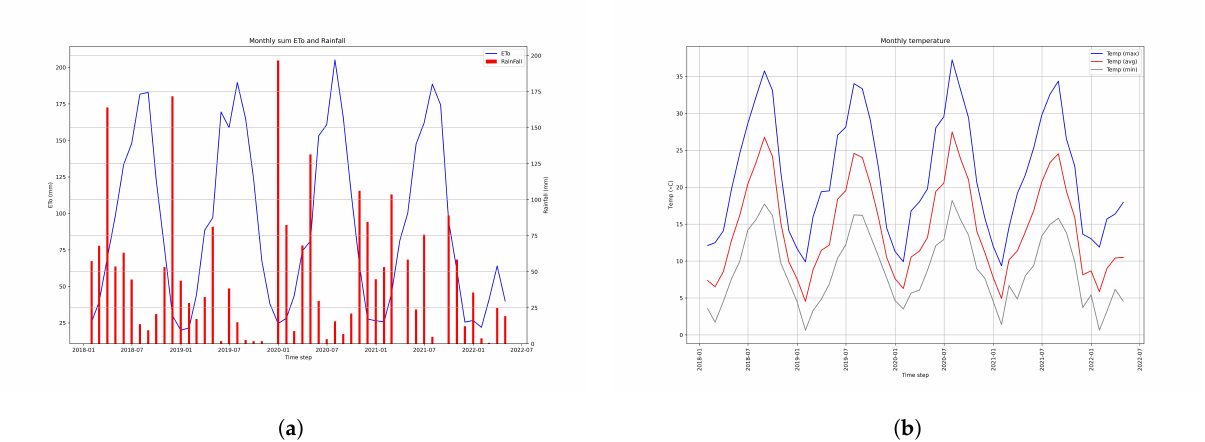
Figure 3. Monthly rainfall and ETo ( a ) and monthly average temperatures ( b ) recorded at the weather station of Colinas do Douro from 2018 to 2021. Table 1. Climate data details of the weather station of Colinas do Douro from 2018 to 2021. The temporal resolutions of all the variables is